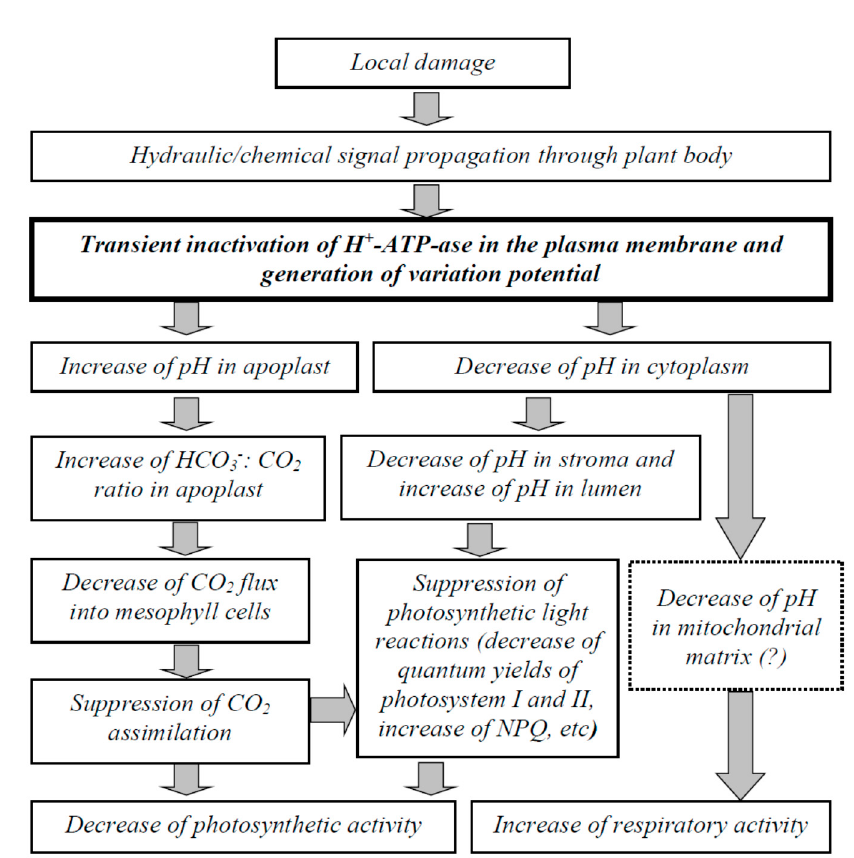
Figure 10. Potential pathways through which the variation potential-related inactivation of H + -ATPase in the plasma membrane influences photosynthesis and respiration. It is hypothesized that local damage induces the propagation of hydraulic and (or) chemical signals, which decrease the activity of H + -ATPase in the plasma membrane (maybe through Ca 2+ flux into the cytoplasm), and thereby generate variation potential. Inactivation of H + -ATPase both increases pH in the apoplast and decreases pH in the cytoplasm. The increased apoplastic pH increases the HCO 3 − /CO 2 ratio in the apoplast and decreases the CO 2 flux into the mesophyll cells through the plasma membrane because CO 2 is more permeable through biological membranes than HCO 3 − . The decreased CO 2 flux induces the suppression of photosynthetic CO 2 assimilation. The decreased pH in the cytoplasm can decrease the pH in the stroma and lumen of chloroplasts; suppression of photosynthetic light reactions (decrease in quantum yields of photosystem I and II, increase in NPQ, etc) is induced by these changes in pH. In contrast, the decreased pH in the cytoplasm can stimulate respiration. The effect is probably caused by the decrease in pH in the mitochondrial matrix and the stimulation of respiratory electron flow. Thus, both the decrease in photosynthetic activity and the increase in respiration are the results of the propagation of variation potentials.